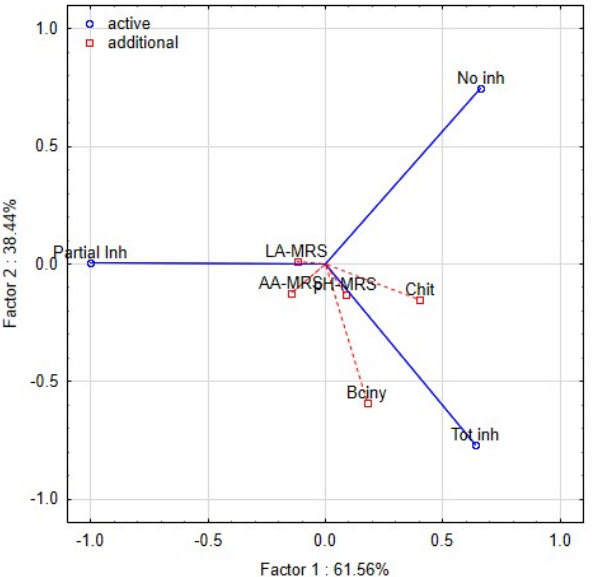
Figure 4. Biplot representing the first two components of PCA performed on the standardised values of index logarithms representing the interaction among lactobacilli and yeast contaminants in the overlay method. The functional properties of lactobacilli are additional factors—pH, LA (lactic acid), AA (acetic acid), Bciny (bacteriocins), Chit (chitinase).